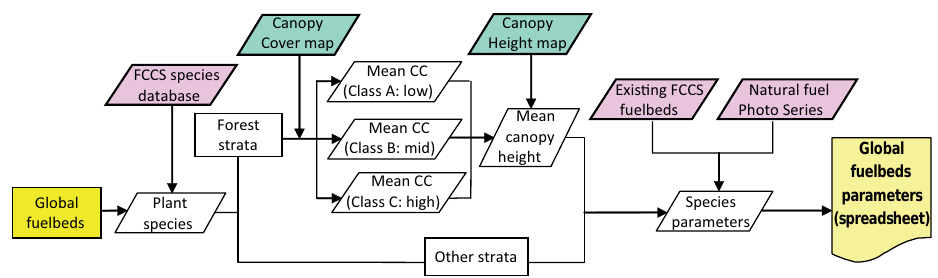
Figure 3. Flow chart of the steps performed for the parameterization of the fuelbeds. CC: canopy cover.